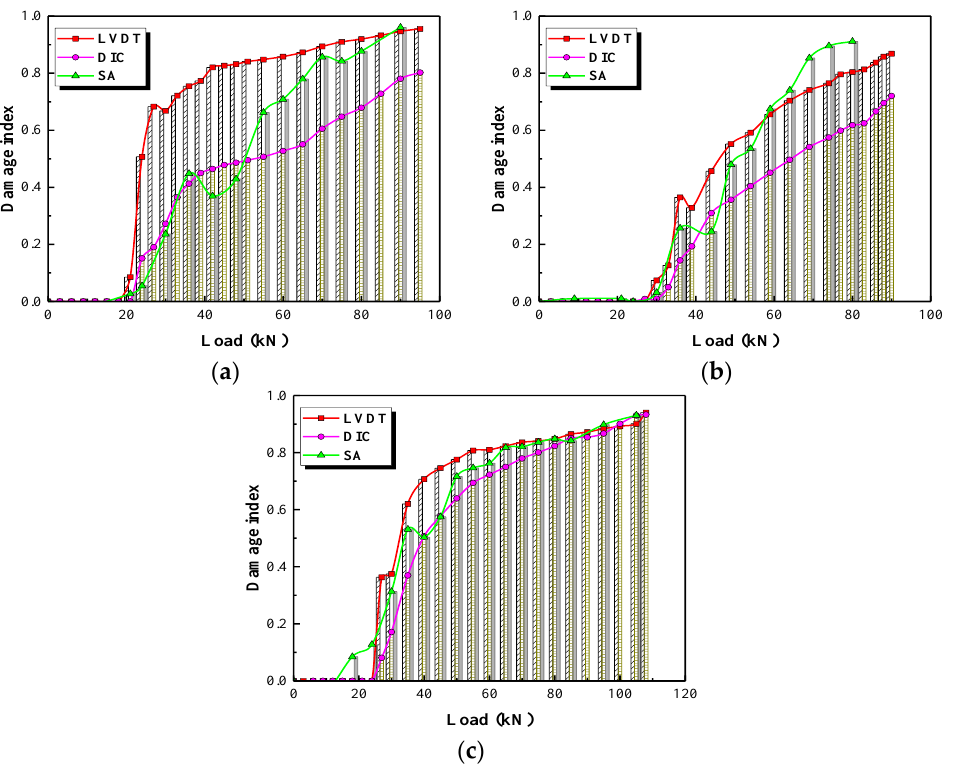
Figure 30. Damage levels of the test specimens. ( a ) Test specimen G1; ( b ) Test specimen G3; ( c ) Test specimen S1.